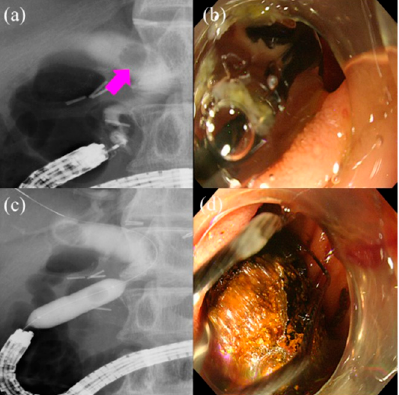
Figure 3. Endoscopic stone extraction using short single-balloon enteroscopy (short SBE) for patients with surgically altered anatomy (SAA): ( a ) Cholangiography showing a 15-mm biliary stone (pink arrow) in the distal bile duct. ( b , c ) Endoscopic papillary large balloon dilation was performed for stone extraction. The balloon was inflated up to 13-mm. ( d ) Stone extraction was completed without crushing.